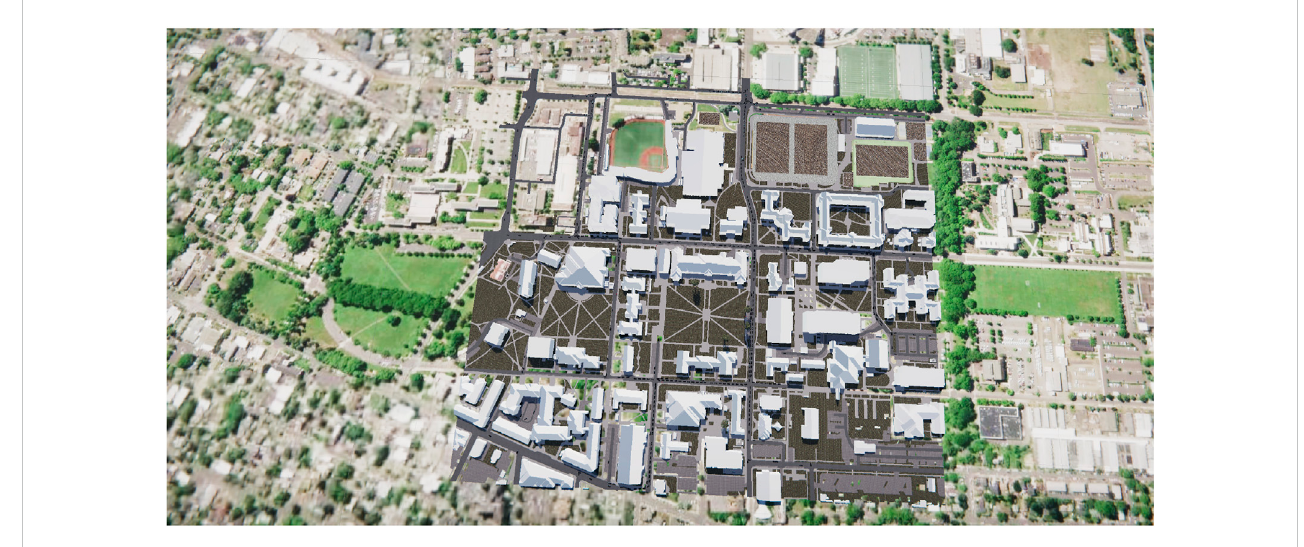
FIGURE 7 OverviewoftherunningsimulationvisualizedinUnity.ThemodelisdisplayedontopofanArcGISOnlinebasemap(©Esri,Maxar,EarthstarGeographics, GIS User Community). The base map was created using ArcGIS ® software by Esri. ArcGIS ® and ArcMap ™ are the intellectual property of Esri and are used herein under license. Copyright © Esri. All rights reserved. For more information about Esri ® software, please visit